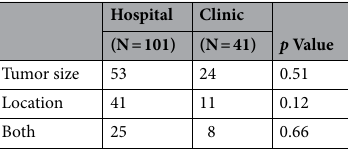
Table 3. Comparisons between the affiliated institutions of referring physicians.